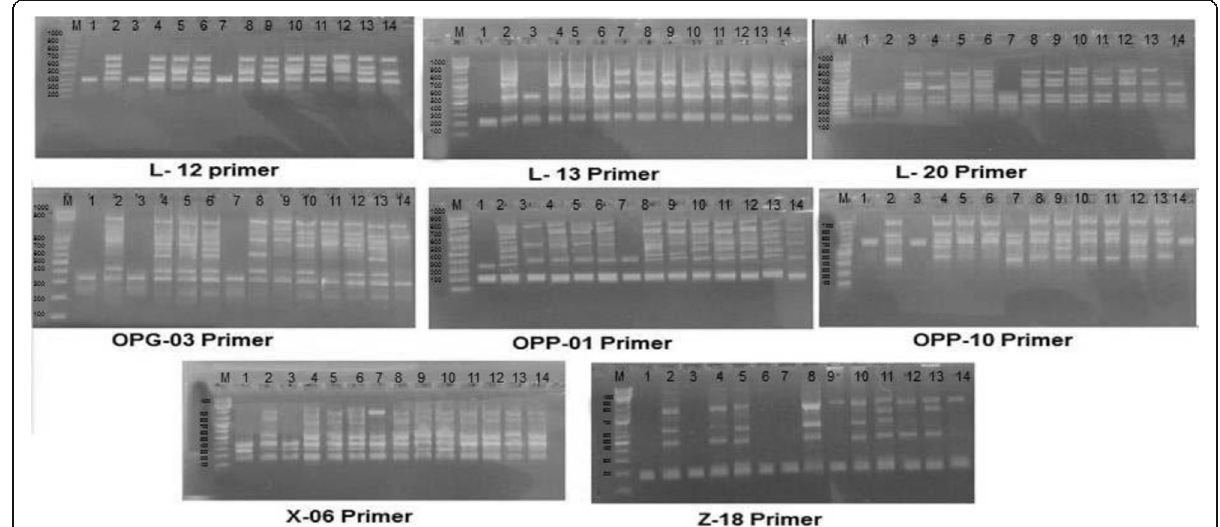
Fig. 1 RAPD profile of the 14 samples of Silybum marianum generated by eight primer. M: 1 kb Plus DNA ladder